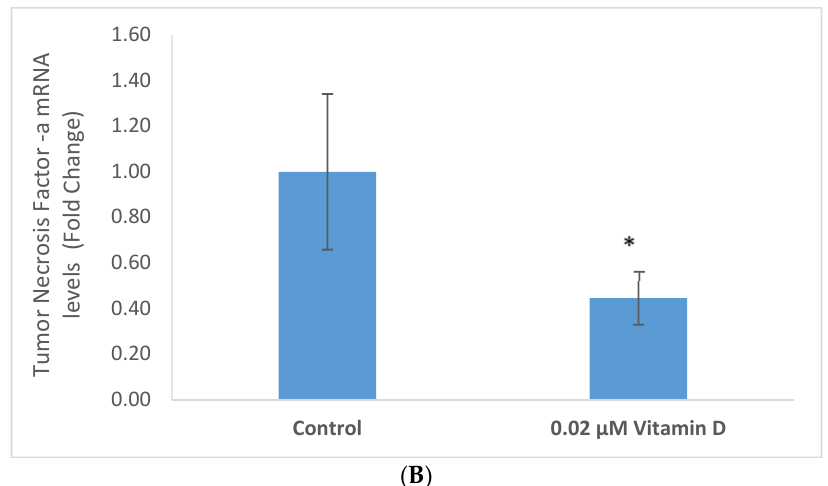
Figure 4. Effect of 0.02 μM 1 ,25-dihydroxyvitamin D3 (vitamin D) on interleukin-1 (IL-1) ( A ), and tumor necrosis factor alpha (TNF-α) ( B ) mRNA levels in melanoma cells; error bars: standard deviation, n = 4; * = p < 0.05, relative to control.